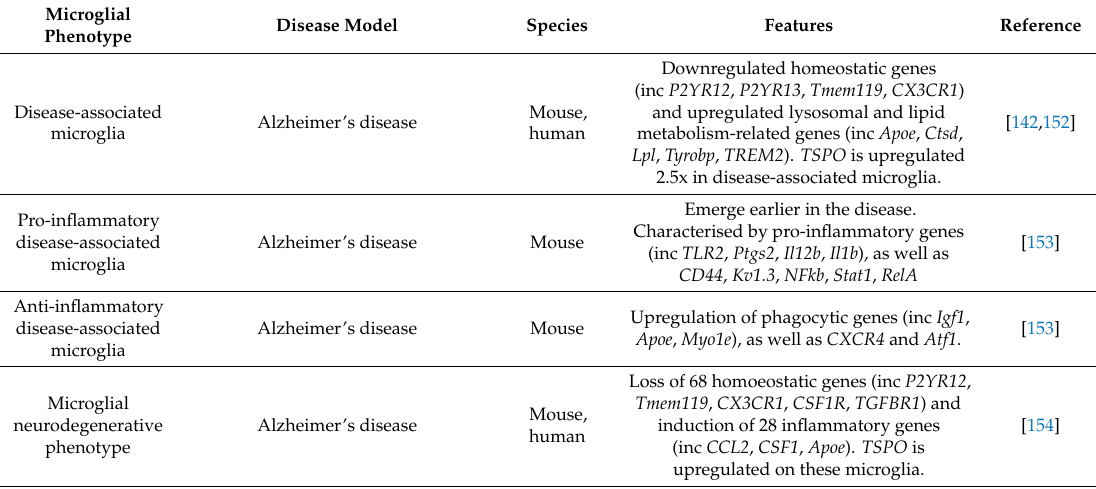
Table 1. Features of new microglial phenotypes from ‘omics studies of neurodegenerative diseases. Microglial